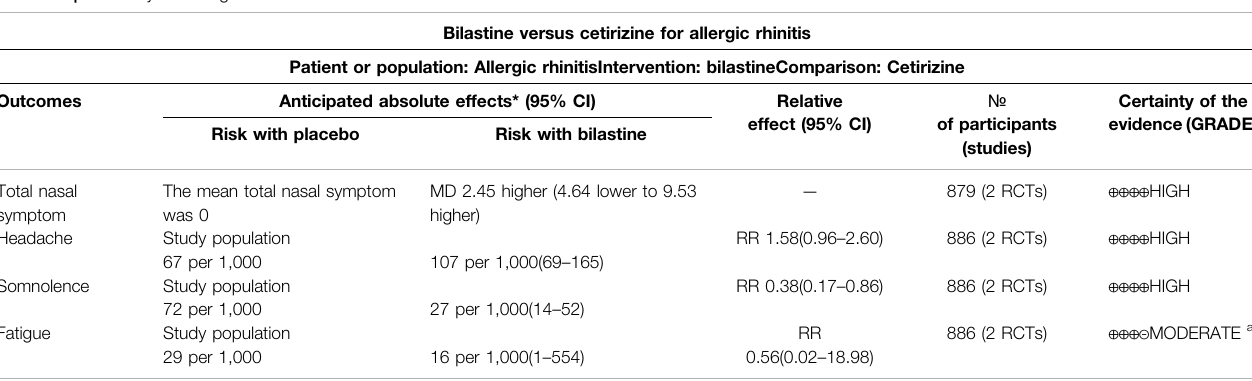
TABLE 3 | Summary of fi ndings for bilastine versus cetirizine.